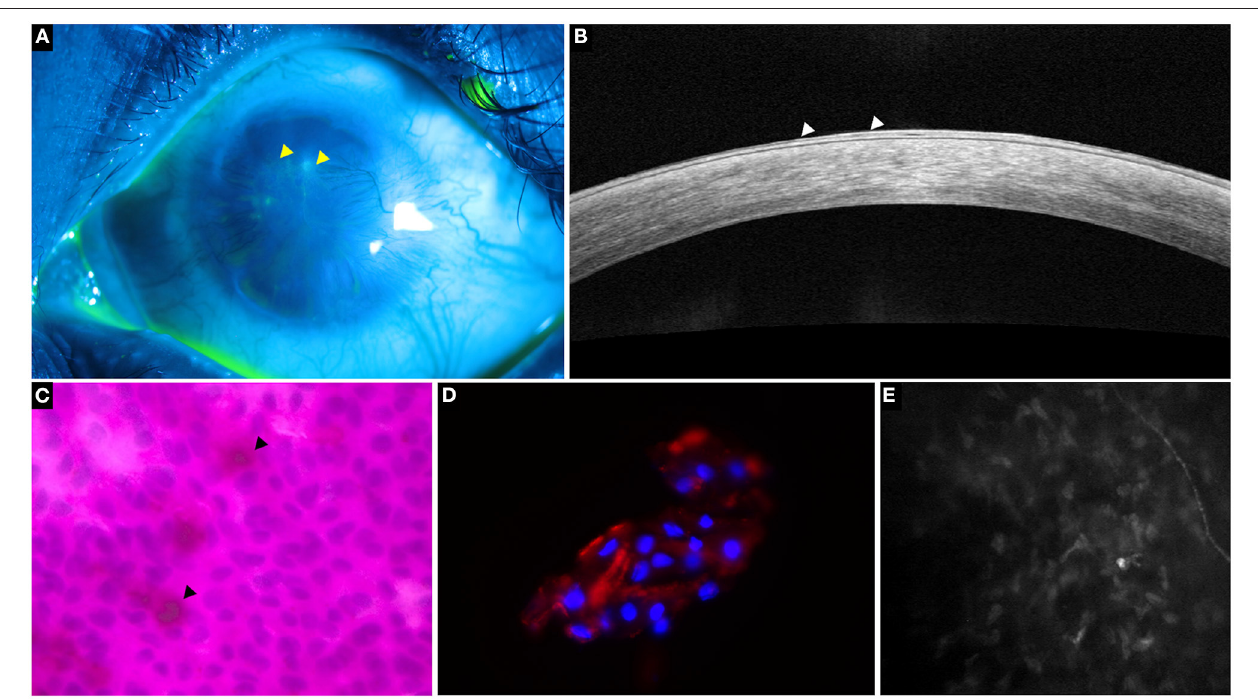
FIGURE 3 | A representative collage of various diagnostic modalities in limbal stem cell deficiency (LSCD). (A) Fluorescein-stained image showing characteristic stippled staining (yellow arrowheads). (B) Optical coherence tomography line scan showing hyperreflective epithelium indicative of LSCD (white arrowheads). (C) Impression cytology depicting Periodic acid-Schiff positive goblet cells (black arrowheads) and CK19 positive cells on immunohistochemistry (D,E) in vivo confocal microscopy showing decreased sub-basal nerve